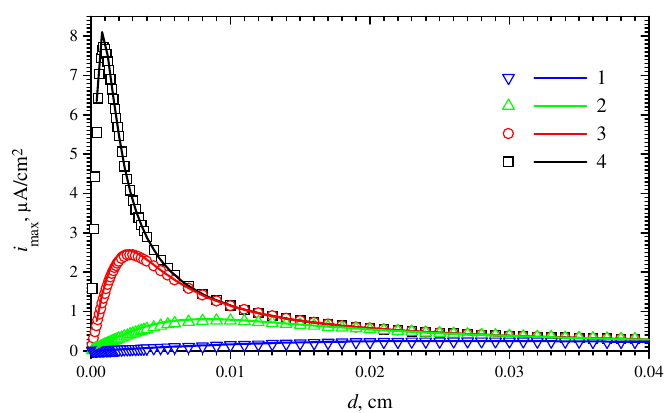
: 10 -9 (1), 10 -8 (2), 10 -7 (3) and 10 -6 (4) max